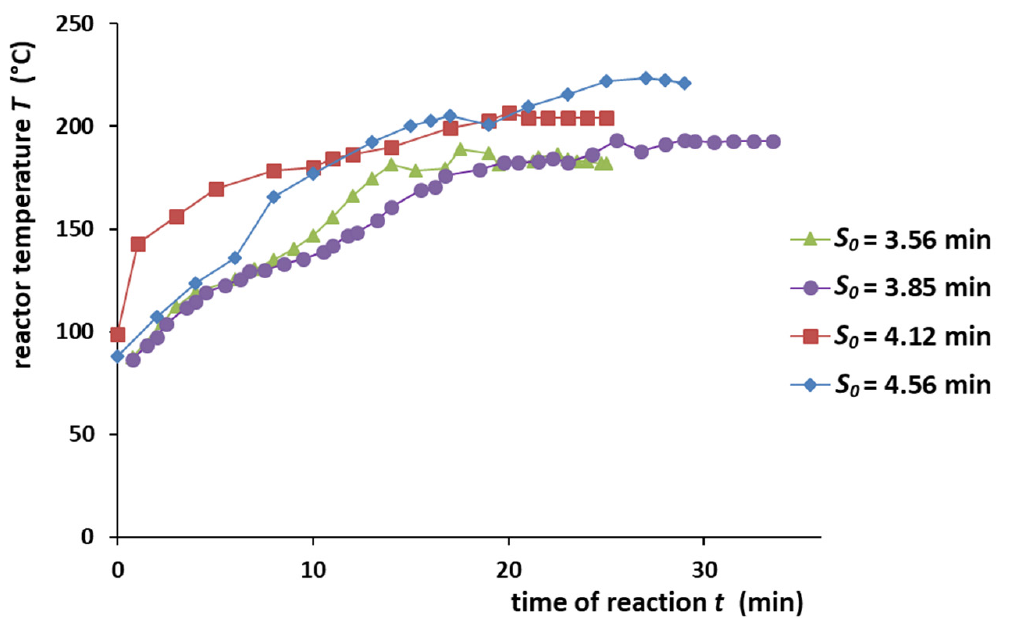
Figure 1. Temperature profile inside the steam explosion reactor, t = 0 min marks the beginning of steam input. steam input. Table 1. Experimental setup for steam explosion of beech wood Table 1. Experimental setup for steam explosion of beech wood chips.